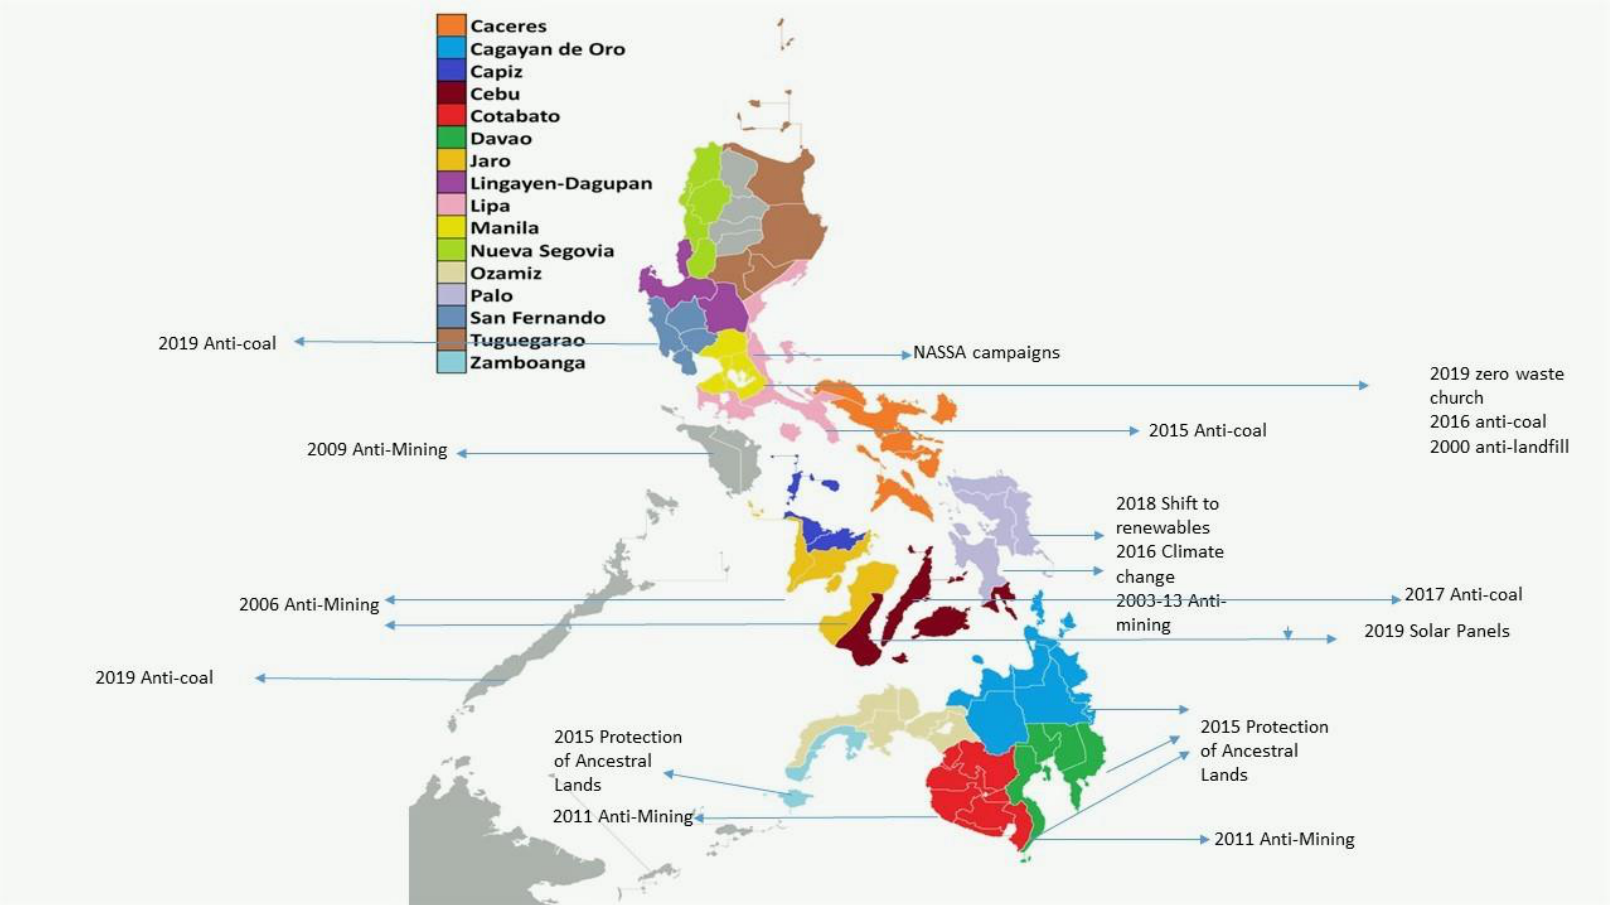
Figure 1. A map of environmental campaigns as concrete responses to the Catholic Bishop Conference of the Philippines (CBCP)’s pastoral letters on the environment. Original image from Howard the Duck (2013) distributed under license CC BY-SA 3.0